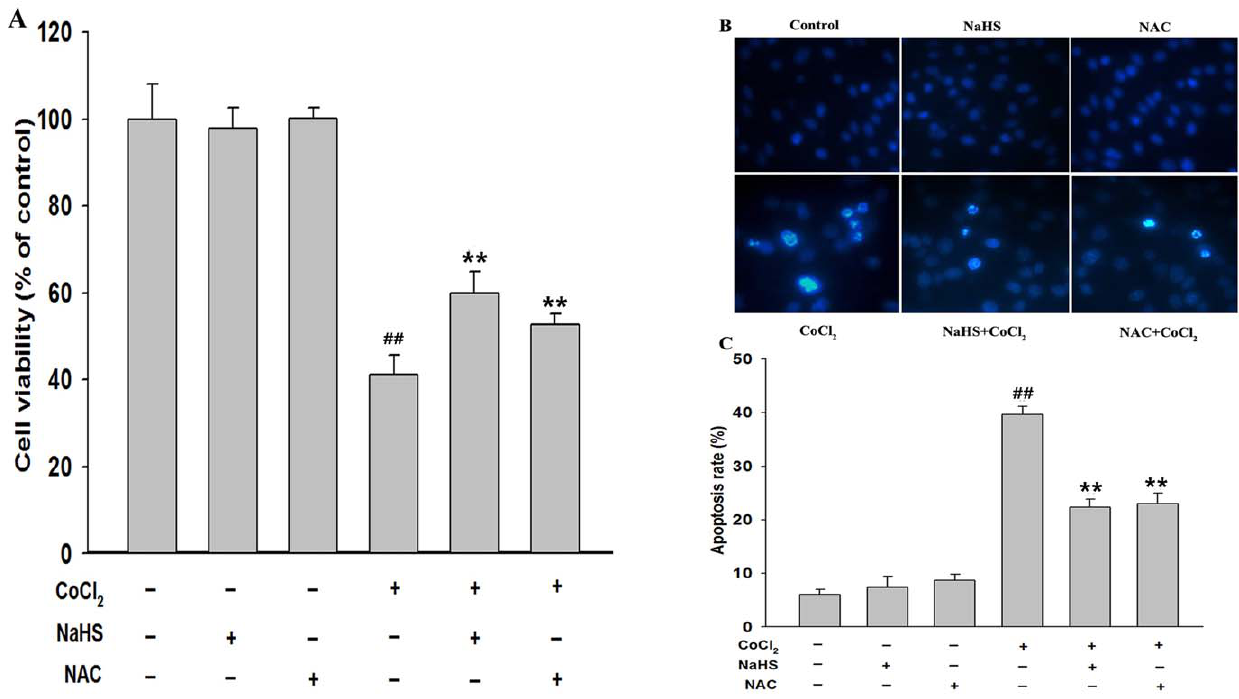
Figure 10. H 2 S and NAC protected PC12 cells against CoCl 2 -induced injuries. (A) The cell viability was assessed by the cell counter kit (CCK- 8) described in ‘Materials and methods’. PC12 cells were treated with the indicated treatments. (B) Morphological changes in apoptotic cells assessed by Hochest 33258 staining. Arrow indicated cells with apoptotic nuclear condensation and fragmentation. Control: untreated cells; NaHS: cells were treated with 400 m mol/L NaHS for 30 min alone; NAC: cells were treated with 500 m mol/L NAC for 60 min alone; CoCl2: cells were treated with 600 m mol/L CoCl 2 for 48 h; NaHS + CoCl 2 : cells were preconditioned with 400 m mol/L NaHS for 30 min prior to treatment with 600 m mol/L CoCl 2 for 48 h; NAC + CoCl 2 : cells were preconditioned with 500 m mol/L NAC for 60 min prior to treatment with 600 m mol/L CoCl 2 for 48 h; (C) The apoptotic rate was analysed with a cell counter of Image J 1.41o software. Data are the mean 6 SE (n=3). ## P , 0.01 compared to the control group, ** P , 0.01 compared to the CoCl